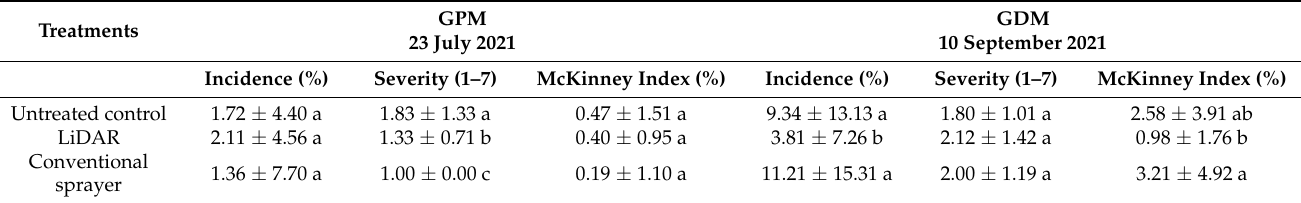
Table 7. Details of grapevine powdery mildew (GPM) and grapevine downy mildew (GDM) in- fections recorded on grapevine bunches in Arcevia vineyard, respectively, on 23 July 2021 and 10 September